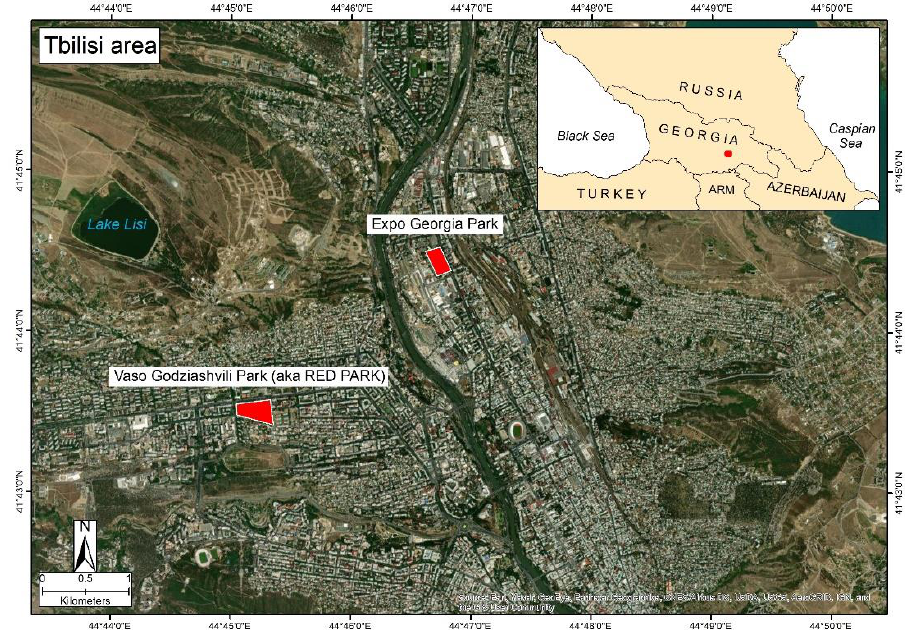
Figure 1. Vaso Godziashvili and EXPO Georgia parks, based on Tbilisi aerial photograph.